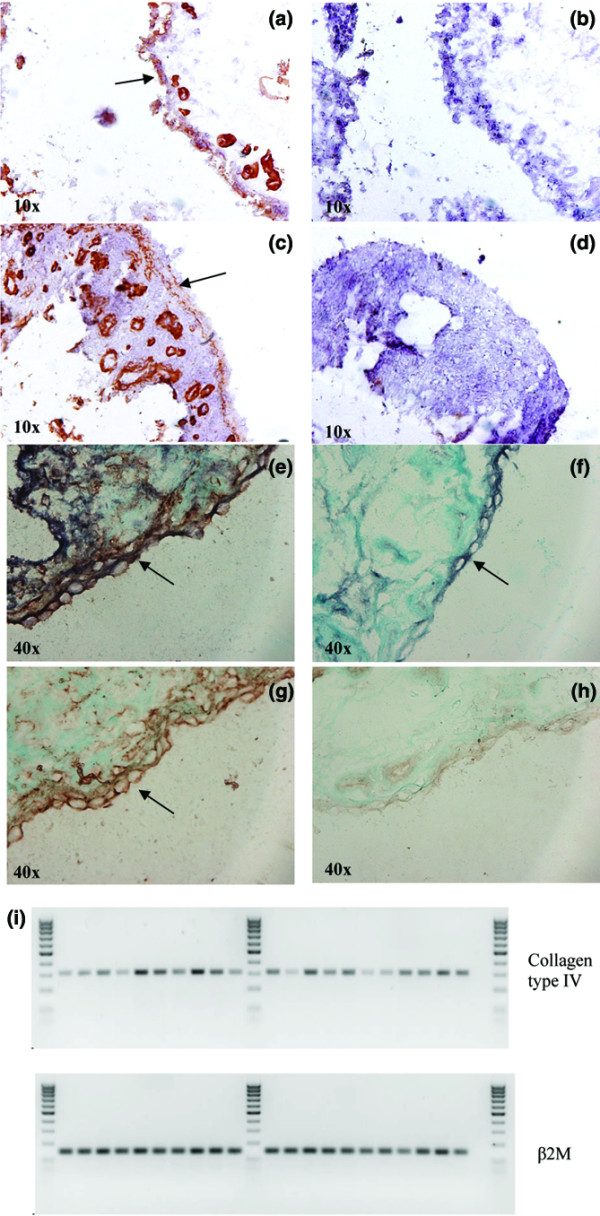
Collagen type IV staining in healthy and arthritic synovial tissue. Collagen type IV was found in the lining layer of synovial biopsies from (a) healthy human subjects and (c) rheumatoid arthritis (RA) patients. Relative isotype controls are shown in (b,d). Double staining was performed to reveal the cellular origin of the type IV collagen. (e) Double staining was found in the lining layer. For a clearer picture, succeeding slices were stained with (f) CD55 or (g) collagen type IV. (h) Isotype control. Arrows indicate collagen IV, CD55 or double staining in the lining layer. (i) PCR results: top, collagen type IV mRNA expression in fibroblast-like synoviocytes from 10 RA patients and 11 healthy controls; bottom, β2-microglobulin (β2M) mRNA expression in the same samples.